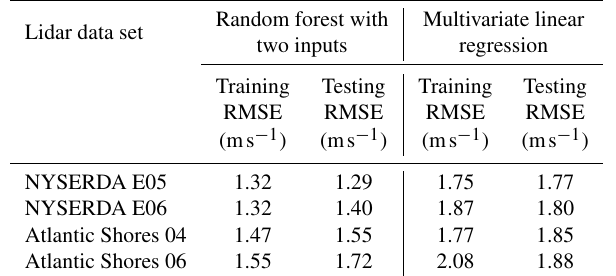
Table 8. Comparison of training and testing RMSE (in modeling hourly average wind speed at 140m) at the four lidar data sets when using a random forest with a reduced number of input variables and a multivariate linear regression with the whole set of input